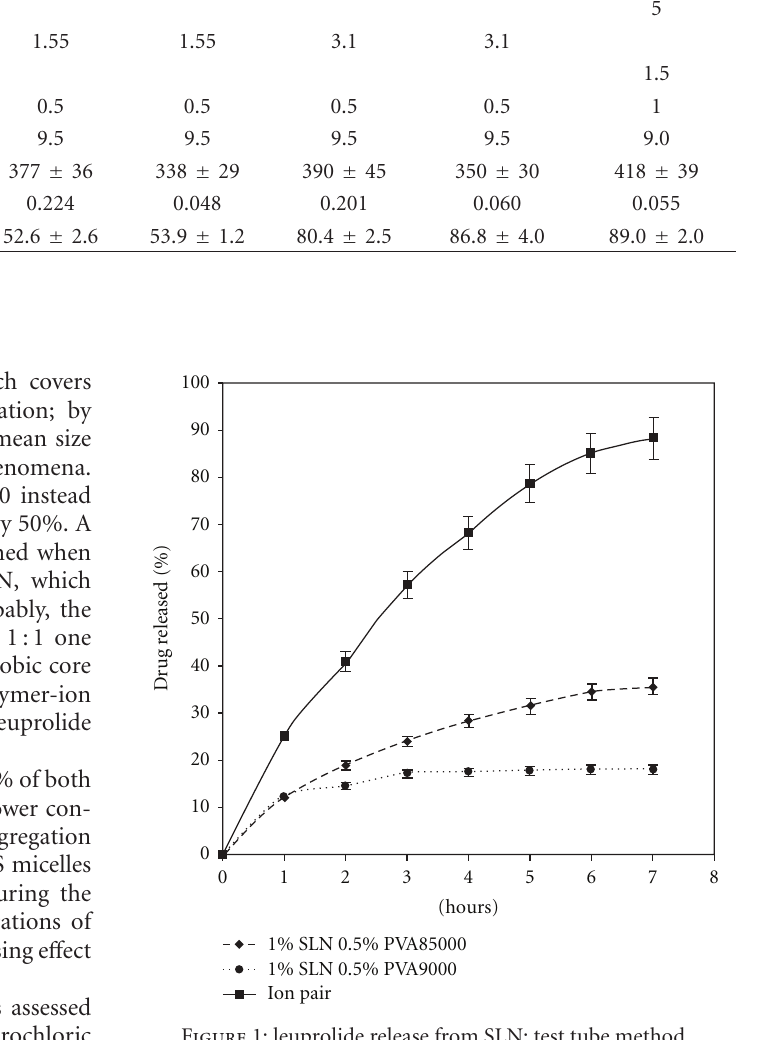
Figure 1: leuprolide release from SLN: test tube